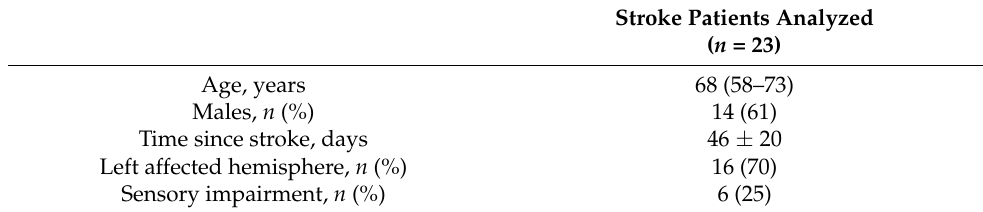
Stroke Patients Analyzed ( n = 23)